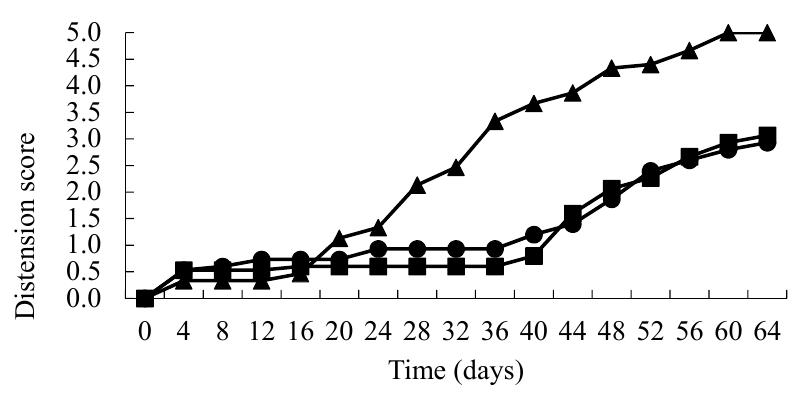
Figure 1. Distension status over time (days) of vacuum packs inoculated with spores of C. estertheticum and packaged in films containing 0 × MIC ( ▲ ), 2.5 × MIC ( ● ) and 3.5 × MIC ( ) AFV.